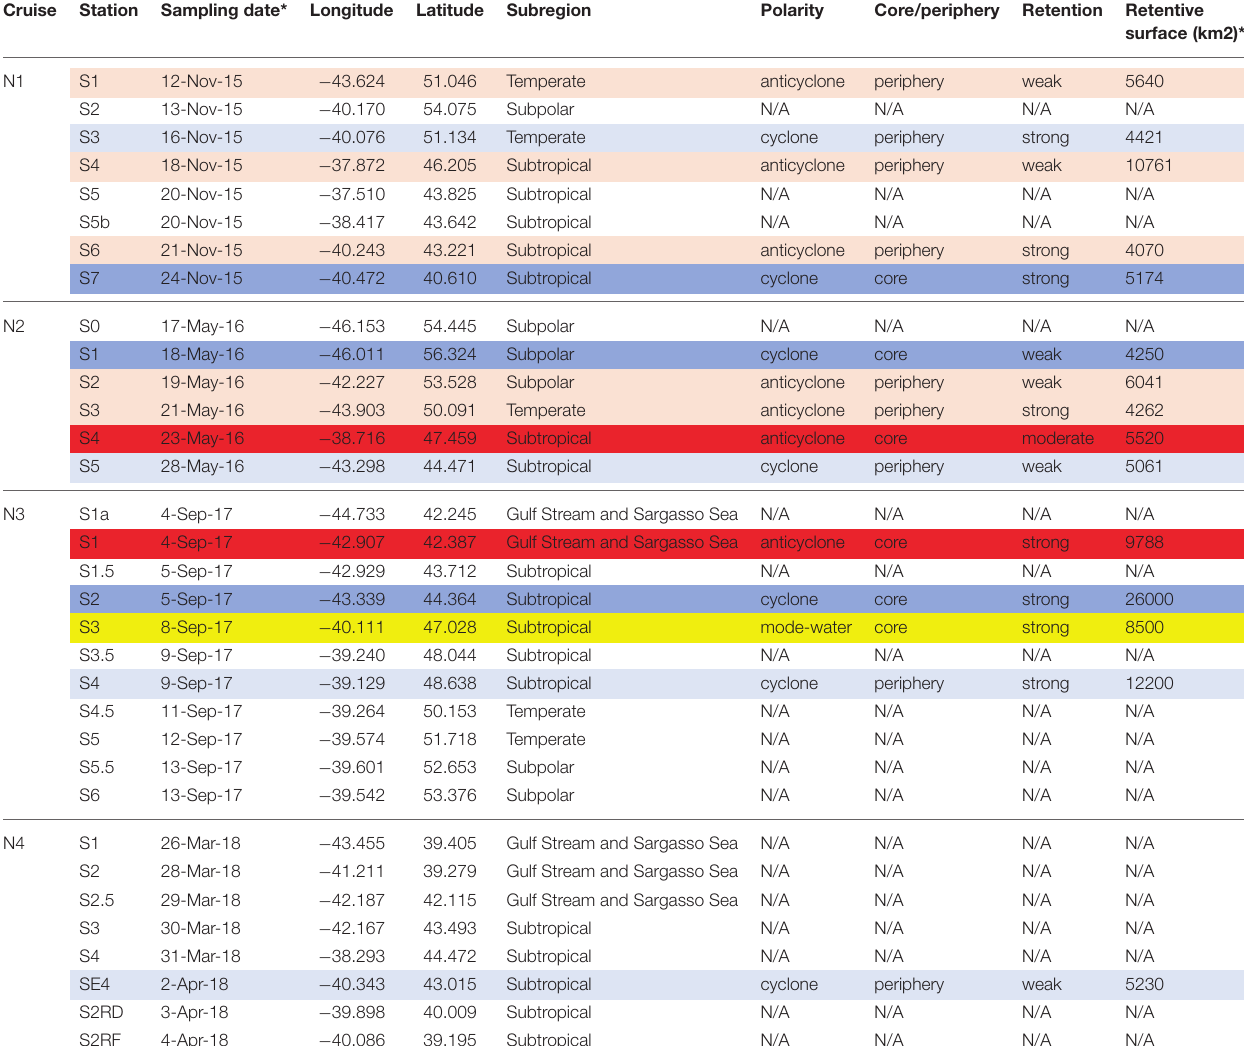
TABLE 1 | Summary of eddy properties for the station sampled during the NAAMES program. Cruise Station Sampling date* Longitude Latitude